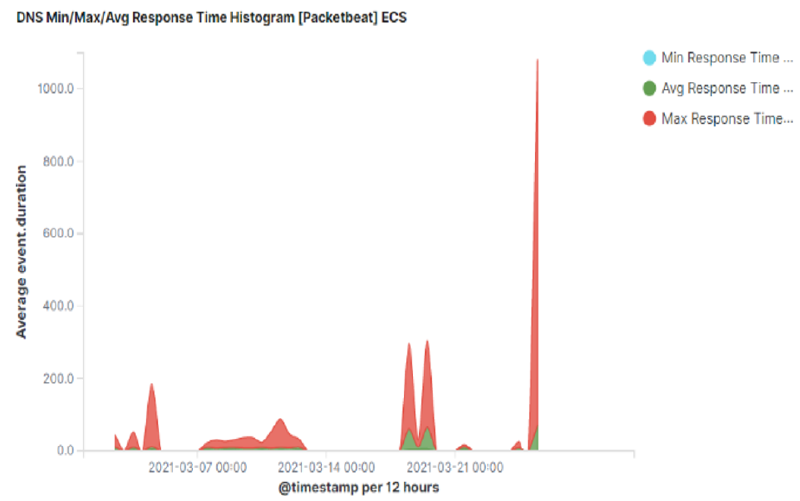
Figure 16. Average time interval between DNS query and